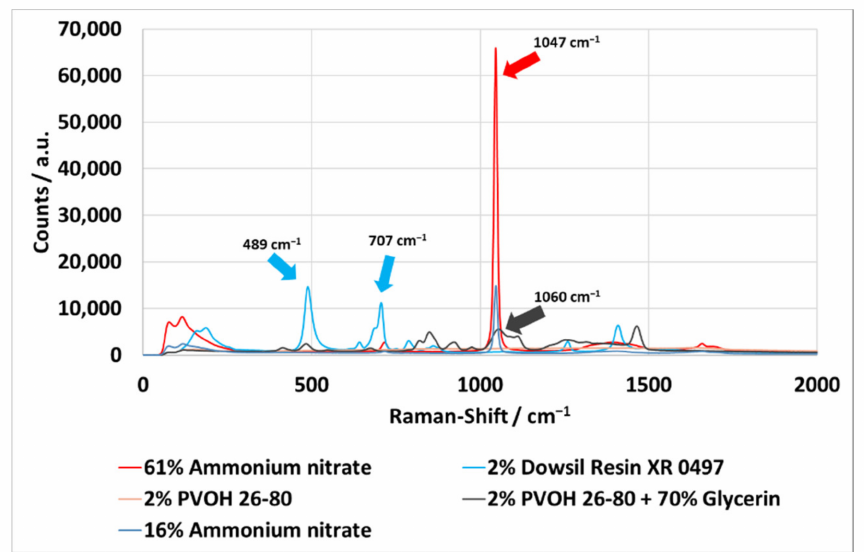
Figure 1. Raman spectra of all phases. For the inner and outer water phase, only the lowest and highest concentrations of ammonium nitrate and glycerol are shown.